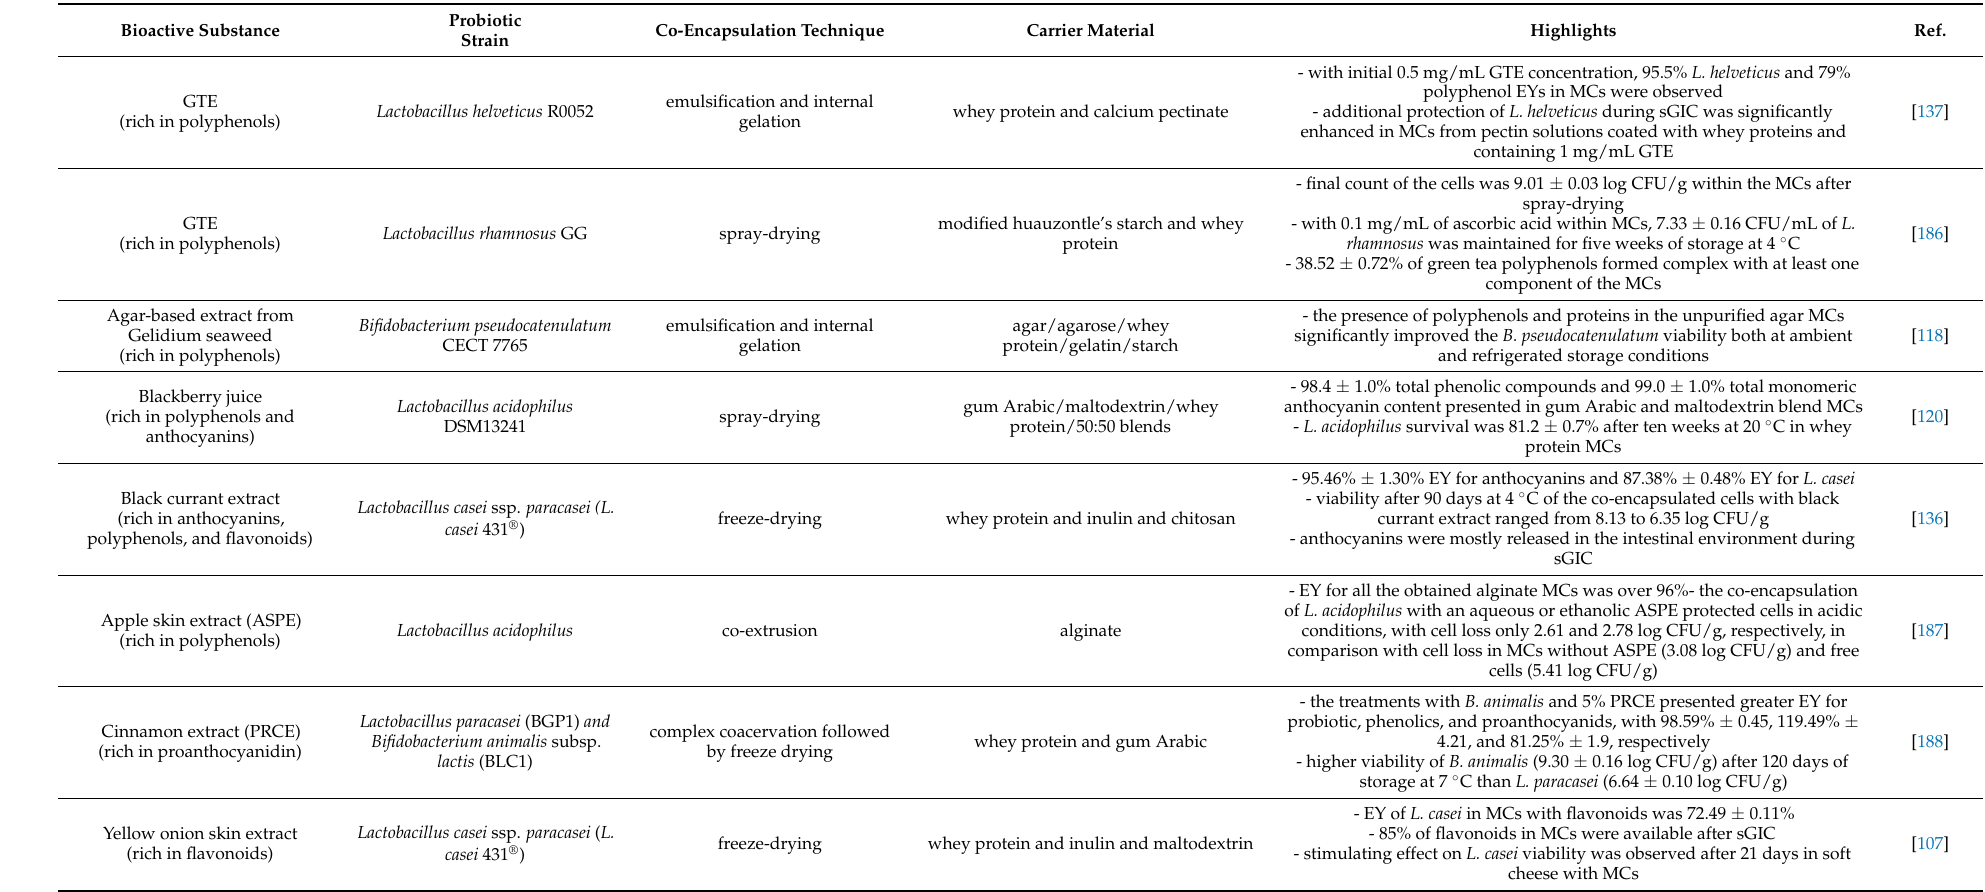
Table 1. Studies of synbiotics comprising different types of